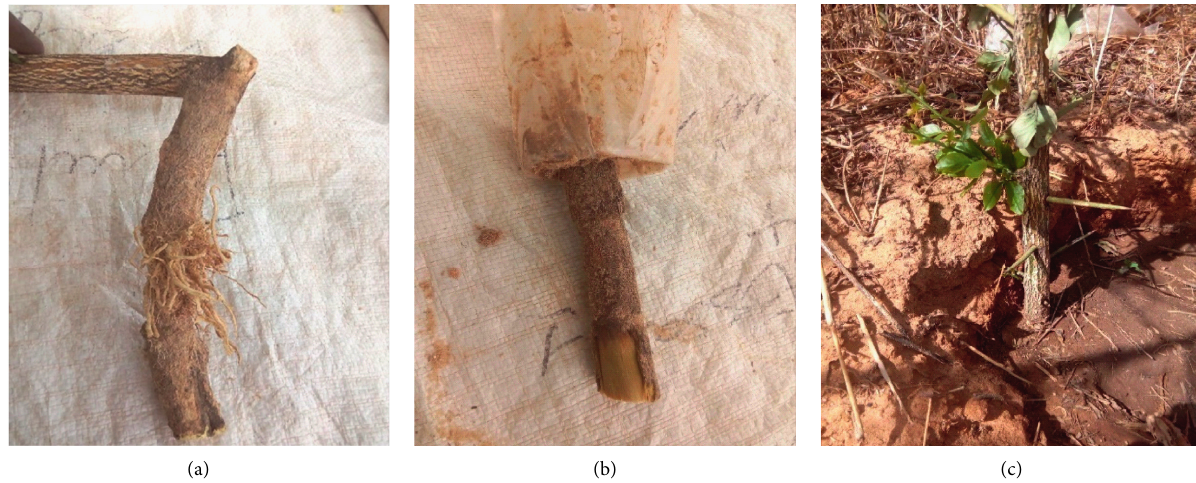
Figure 5: Parameters for air-layering of Balanites aegyptiaca at the Regional Centre for Agricultural Research (CERRA), Maradi, Niger. The marcots having developed the